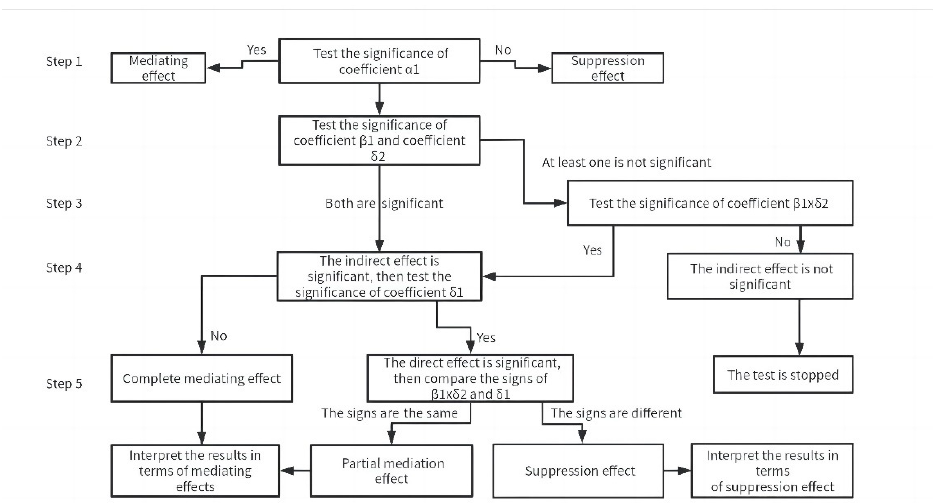
Figure 2. Technical